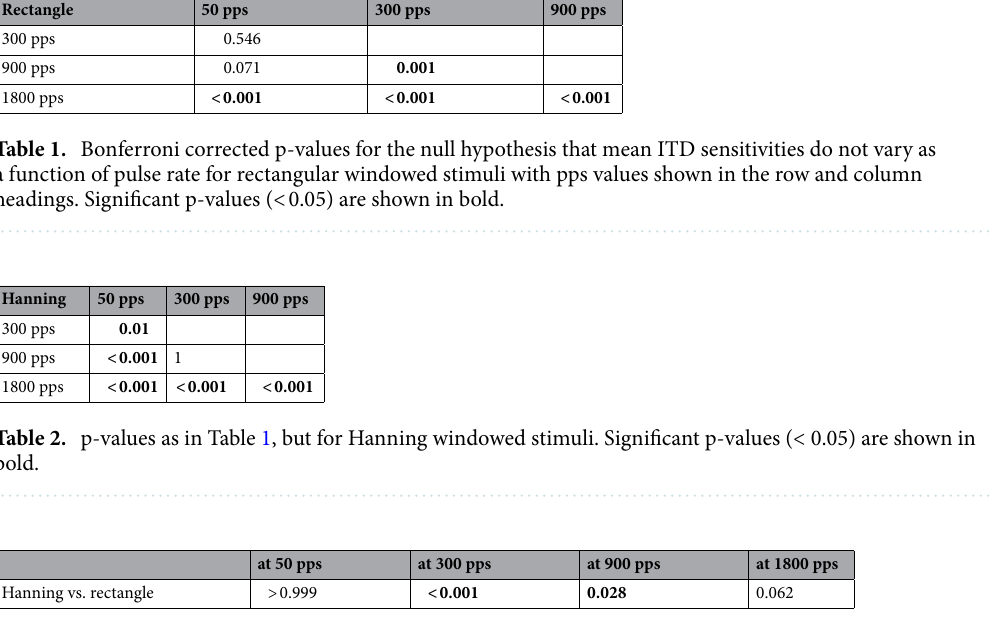
Table 3. Bonferroni corrected p-values for the null hypothesis that mean ITD sensitivities do not vary as a function of envelope shape, rectangular or Hanning windowed stimuli, when tested at the pps values shown in the column headings. Significant p-values (< 0.05) are shown in